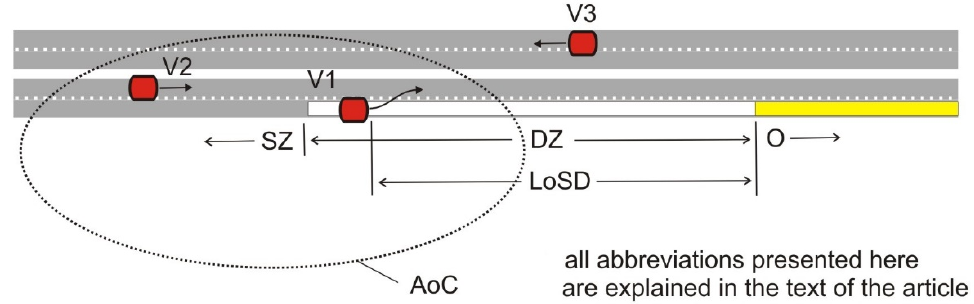
Figure 1. The model for case 1: Obstructions on the road caused by maintenance works or other factors.